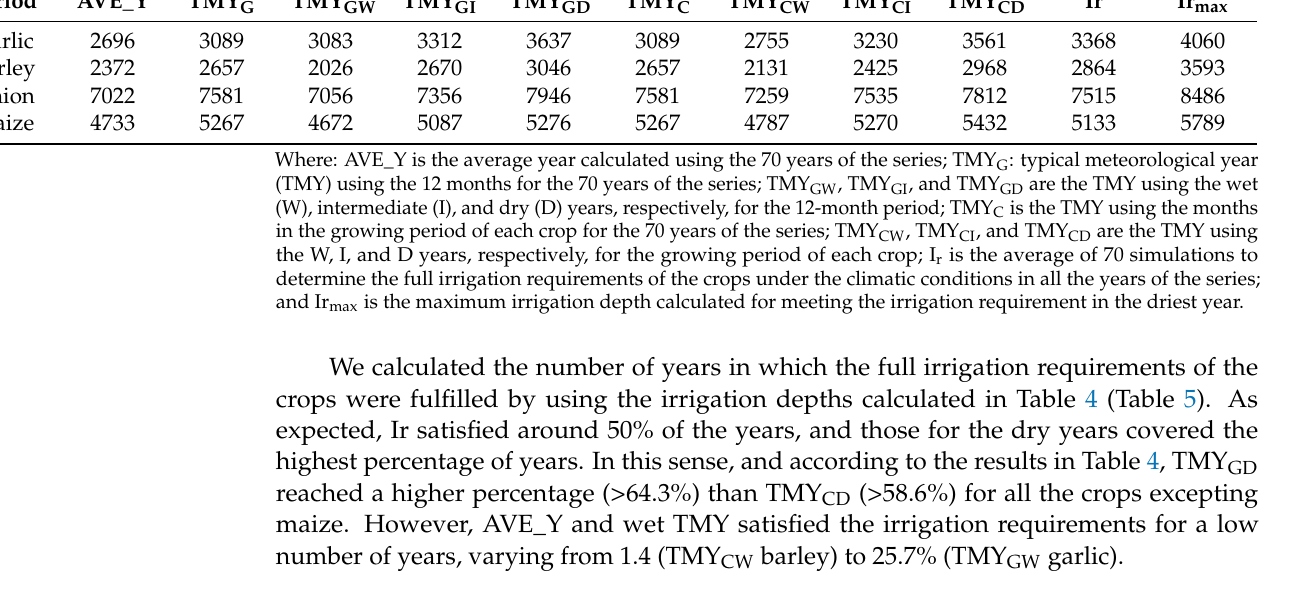
Table 5. Percentage of years in which the net irrigation requirements of crops were fulfilled